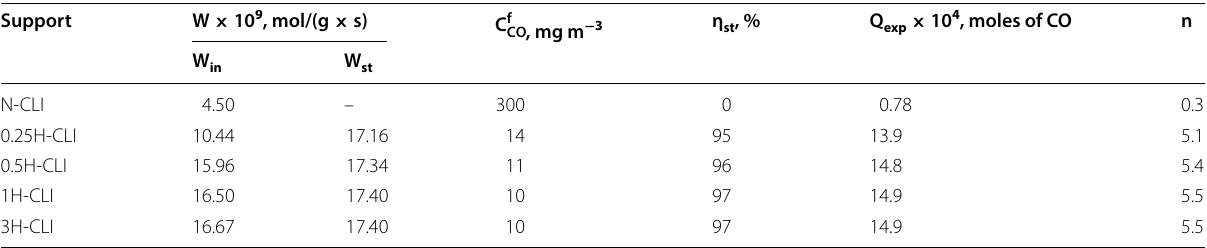
Table 6 Kinetic and stoichiometric parameters of the reaction of CO oxidation in the presence of K catalysts (S is N-CLI or H-CLIs)